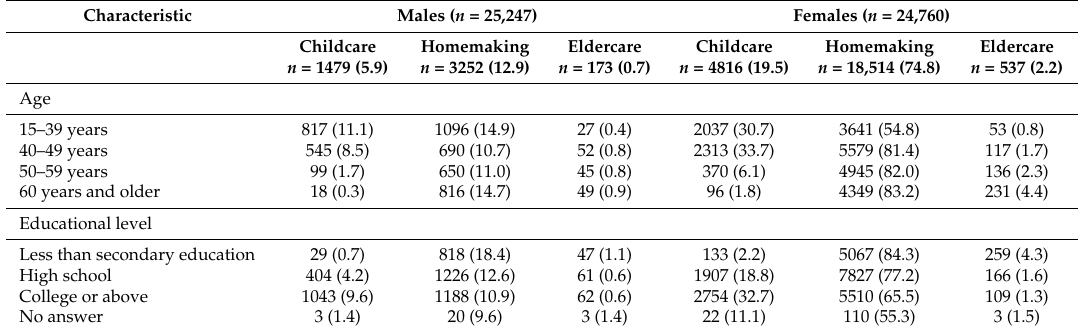
Table 2. Prevalence of family demands by sociodemographic variables, work demands, and WLC, n (%). Characteristic Males ( n = 25,247) Females ( n =